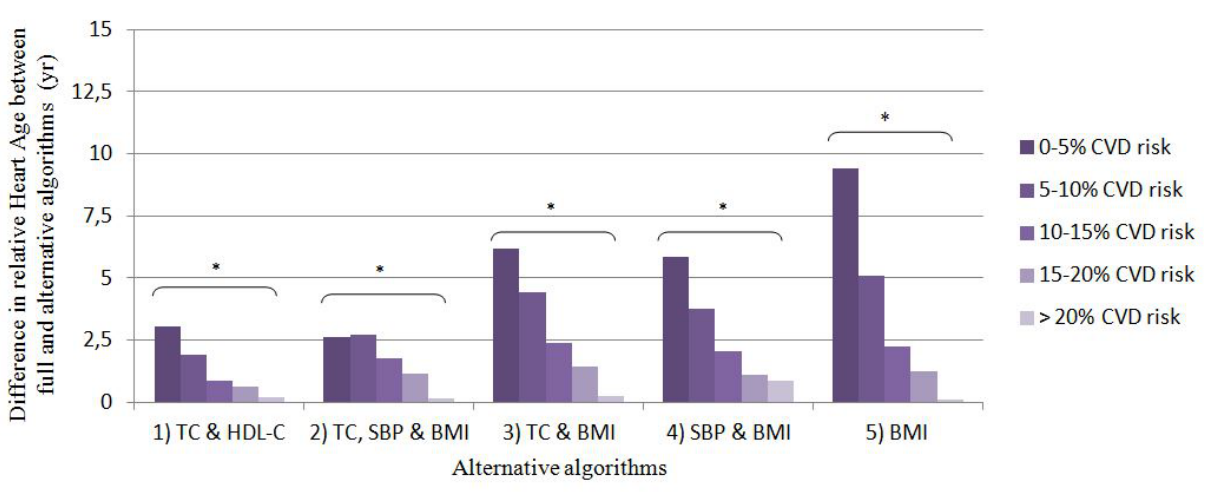
Figure 3. Mean difference in relative Heart Age (i.e. the difference between users’ Heart Age and chronological age) between the full and alternative algorithms per category of absolute 10 year CVD risk based on Framingham risk score [18]. The analysis was restricted to a sub-sample of users with complete valid values for total cholesterol (TC), HDL-cholesterol (HDL-C), systolic blood pressure (SBP) and BMI (n=173,397), and adjusted for age, gender and country where appropriate. Means are estimated marginal means. * significantly different, p <